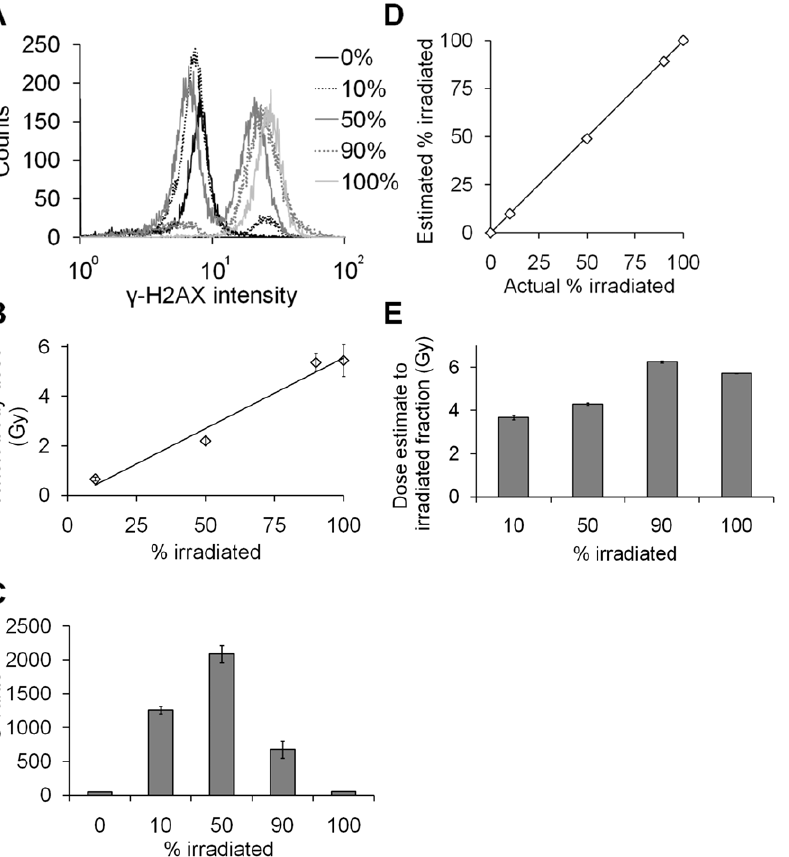
Figure 4. Flow cytometric c -H2AX intensity analysis of a mixture of 4 Gy-irradiated and unirradiated lymphocytes. (A) c -H2AX intensity histograms for different irradiated fractions at 1 hour post exposure. (B) Equivalent whole body dose estimates based on mean intensity measurements from Figure 4A and the intensity calibration function presented in Figure 2C. (C) Poisson U values calculated for c -H2AX intensity distributions in partially irradiated lymphocytes. (D) Estimated versus actual irradiated fraction for the different partial exposures. Estimated fraction was calculated using the contaminated Poisson method. The line indicates a one-to-one correlation. (E) Dose estimates to the irradiated fraction.